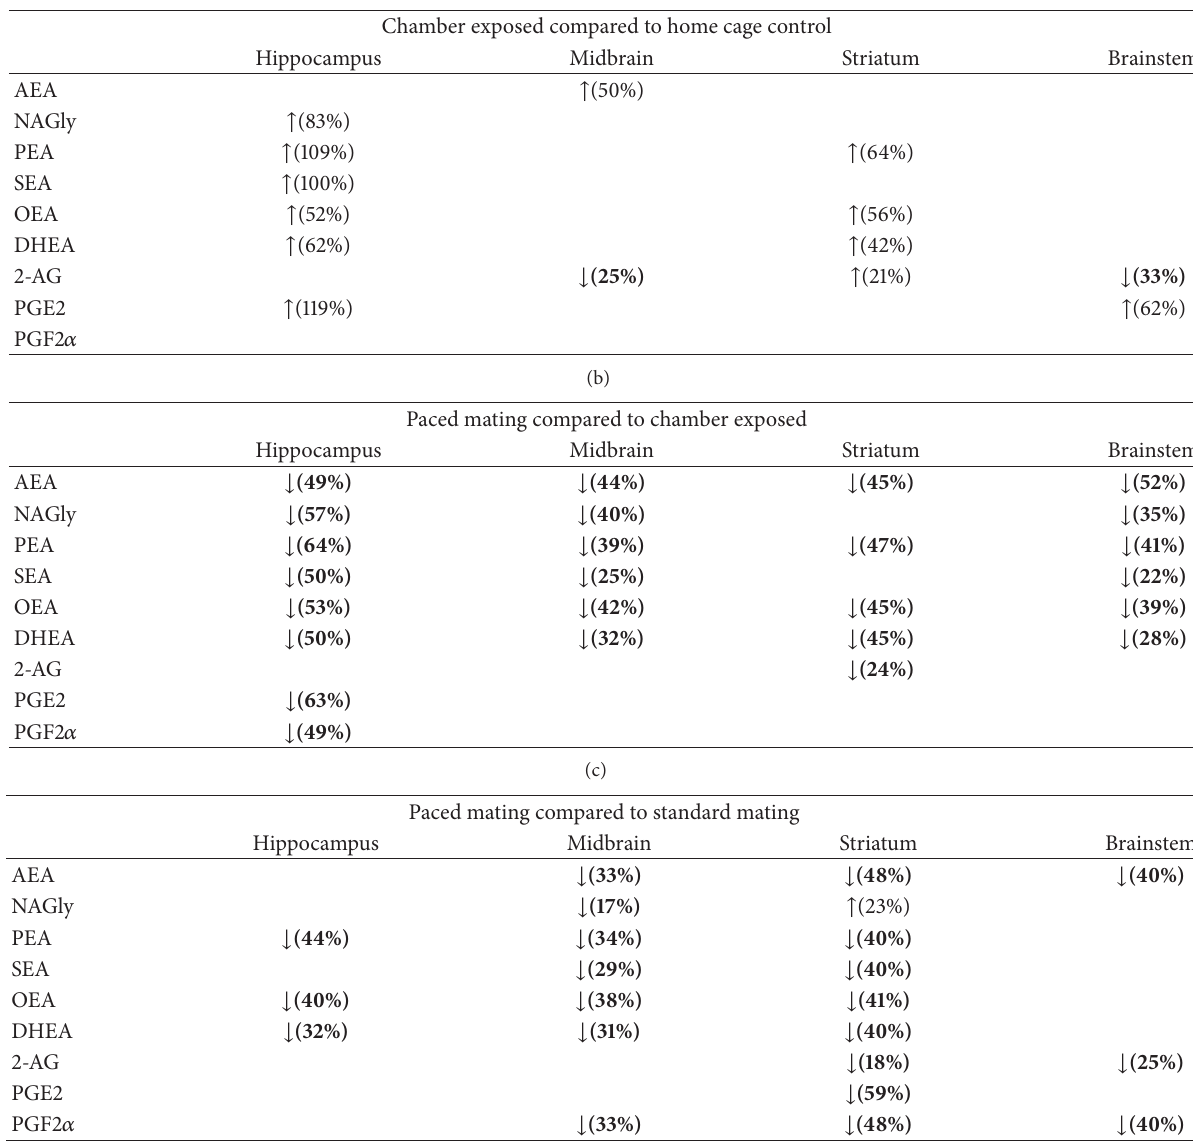
Table 7: Percent difference in the production of nine lipid signaling molecules in midbrain, striatum, and hippocampus. (a–c) Percent change of N -arachidonoyl ethanolamine (anandamide; AEA); N -arachidonoyl glycine (NAGly); N-palmitoyl ethanolamine (PEA); N- stearoyl ethanolamine (SEA); N-oleoyl ethanolamine (OEA); N-docosahexaenoyl ethanolamine (DHEA); 2-arachidonoyl glycerol (2-AG); prostaglandin E2 (PGE2); and prostaglandin F2 alpha (PGF2 𝛼 ). Comparisons are from (a) home cage, (b) chamber exposed, and (c) standard mated. Only percent differences of those means that were significantly different are shown. Averages and analysis of significant differences are shown in Tables 4, 5, and 6. (a) Chamber exposed compared to home cage control Hippocampus Midbrain Striatum